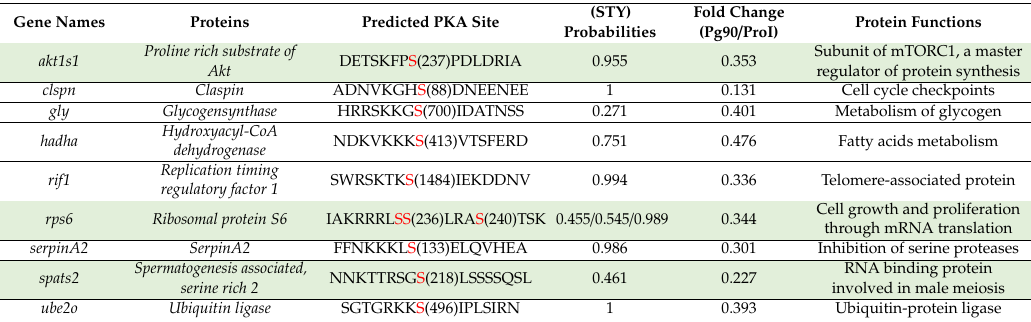
Table 3. Putative PKA substrates in fully-grown Xenopus oocytes. Proteins bearing a PKA consensus site (R / K-R / K-X-S / T-X hydrophobic ) in which the phosphorylation level of the S / T residue at position 4 of the motif decreases in the response of progesterone (Pg). “Phospho (STY) probabilities” estimate the likelihood of the residue highlighted in red to be phosphorylated. “FC (Pg90 / ProI)” is the fold change of the level of phosphorylation detected in oocytes stimulated for 90 min with progesterone as compared to unstimulated prophase-arrested oocytes. In green are highlighted the genes whose function is connected to the control of protein